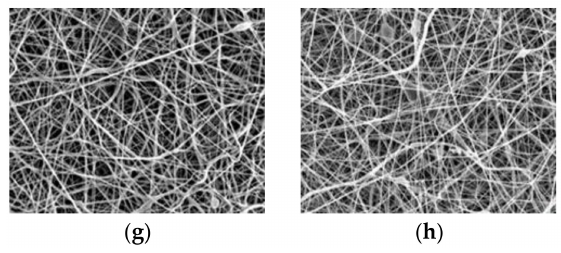
Figure 4. SEM images of block type PUSX nanofibers. ( a ) PU, ( b ) Si01, ( c ) Si02, ( d ) Si03, ( e ) Si04, ( f ) Si01-20, ( g ) Si01-40, and ( h ) Si01-59 under optimized conditions. (Magnification: 2000, DMF:MEK = 64:36). Table 3. Average diameters of block type PUSX nanofibers under optimized spinning